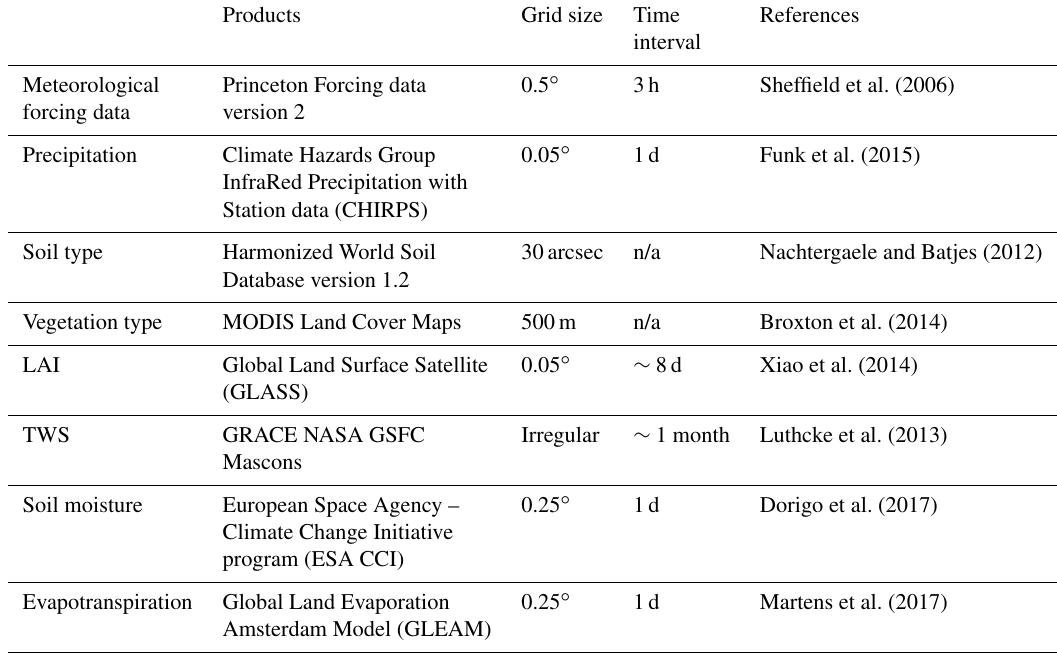
“n/a” stands for not